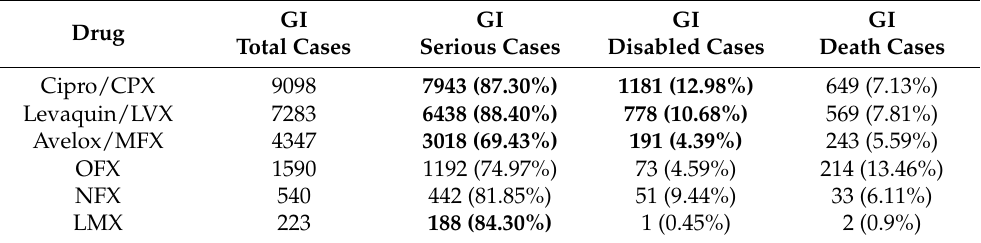
Table 2. Summary of the total number of gastrointestinal defined as serious, disabling, or associated with death. Bolded values indicate the possibility of a relationship between a drug and an adverse drug reaction as analyzed through chi-square analysis. CPX, ciprofloxacin; GI, gastrointestinal; LVX, levofloxacin; MFX, moxifloxacin; NFX, norfloxacin; OFX, ofloxacin; LMX, lomefloxacin.